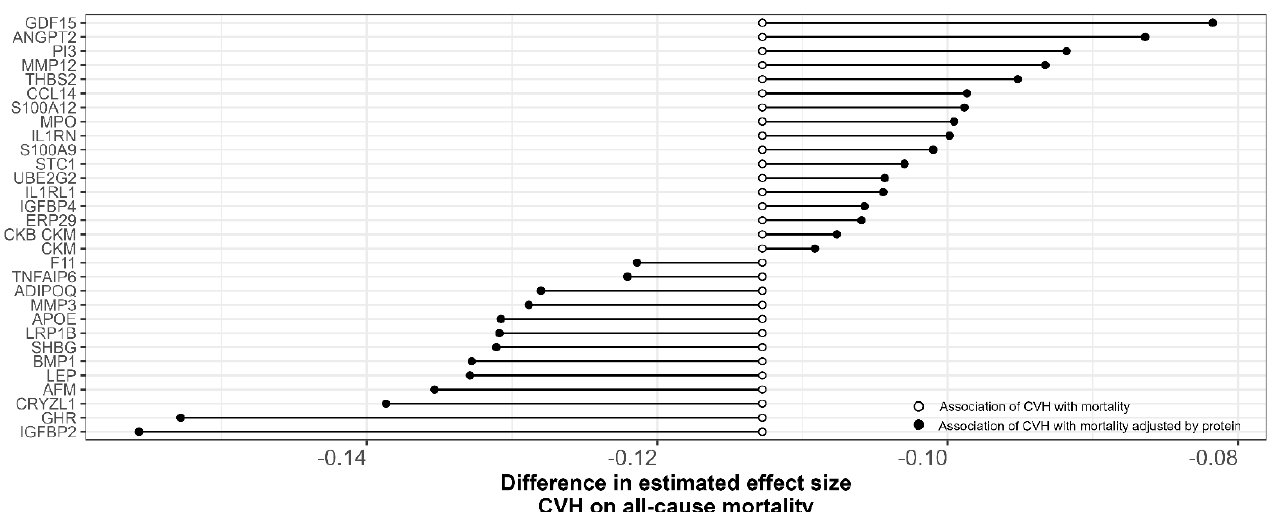
total cholesterol, fasting glucose, and body mass index (BMI). None of the CVH associated proteins were associated with dietary intake component.